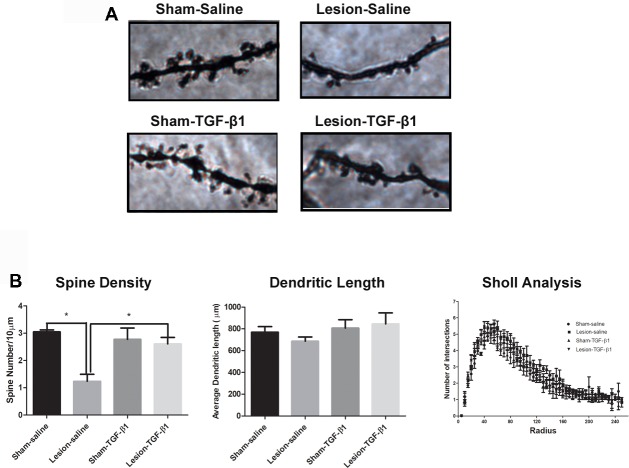
Effect of neonatal TGF-β1 administration on dendritic complexity and spine density in sham and NVHL animals within medial PFC at PD60. (A) Photomicrograph showing representative golgi-cox impregnated basilar dendrite from pyramidal neuron of layer III medial PFC at PD60 in sham-saline, lesion-saline, sham- TGF-β1 and lesion- TGF-β1 groups. (B) Two-way ANOVA showed a significant lesion × TGF-β1 treatment interaction on dendritic spine density (number of spines per 10 μm; *p = 0.02). Total dendritic length (μm) did not change significantly as a result of lesion × TGF-β1 treatment interaction among the four groups (*p = 0.41). Data analysis from dendritic complexity as measured by sholl analysis (Number of dendritic intersections per each sholl radius 5 μm) did not reveal any significant lesion × TGF-β1 treatment × dendritic intersections interaction between the four groups (n = 3–4 per group).